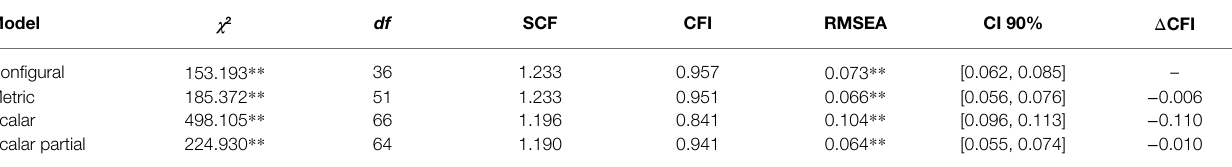
TABLE 7 | Multigroup Measurement Invariance of OB-GSE across all samples. Model Configural